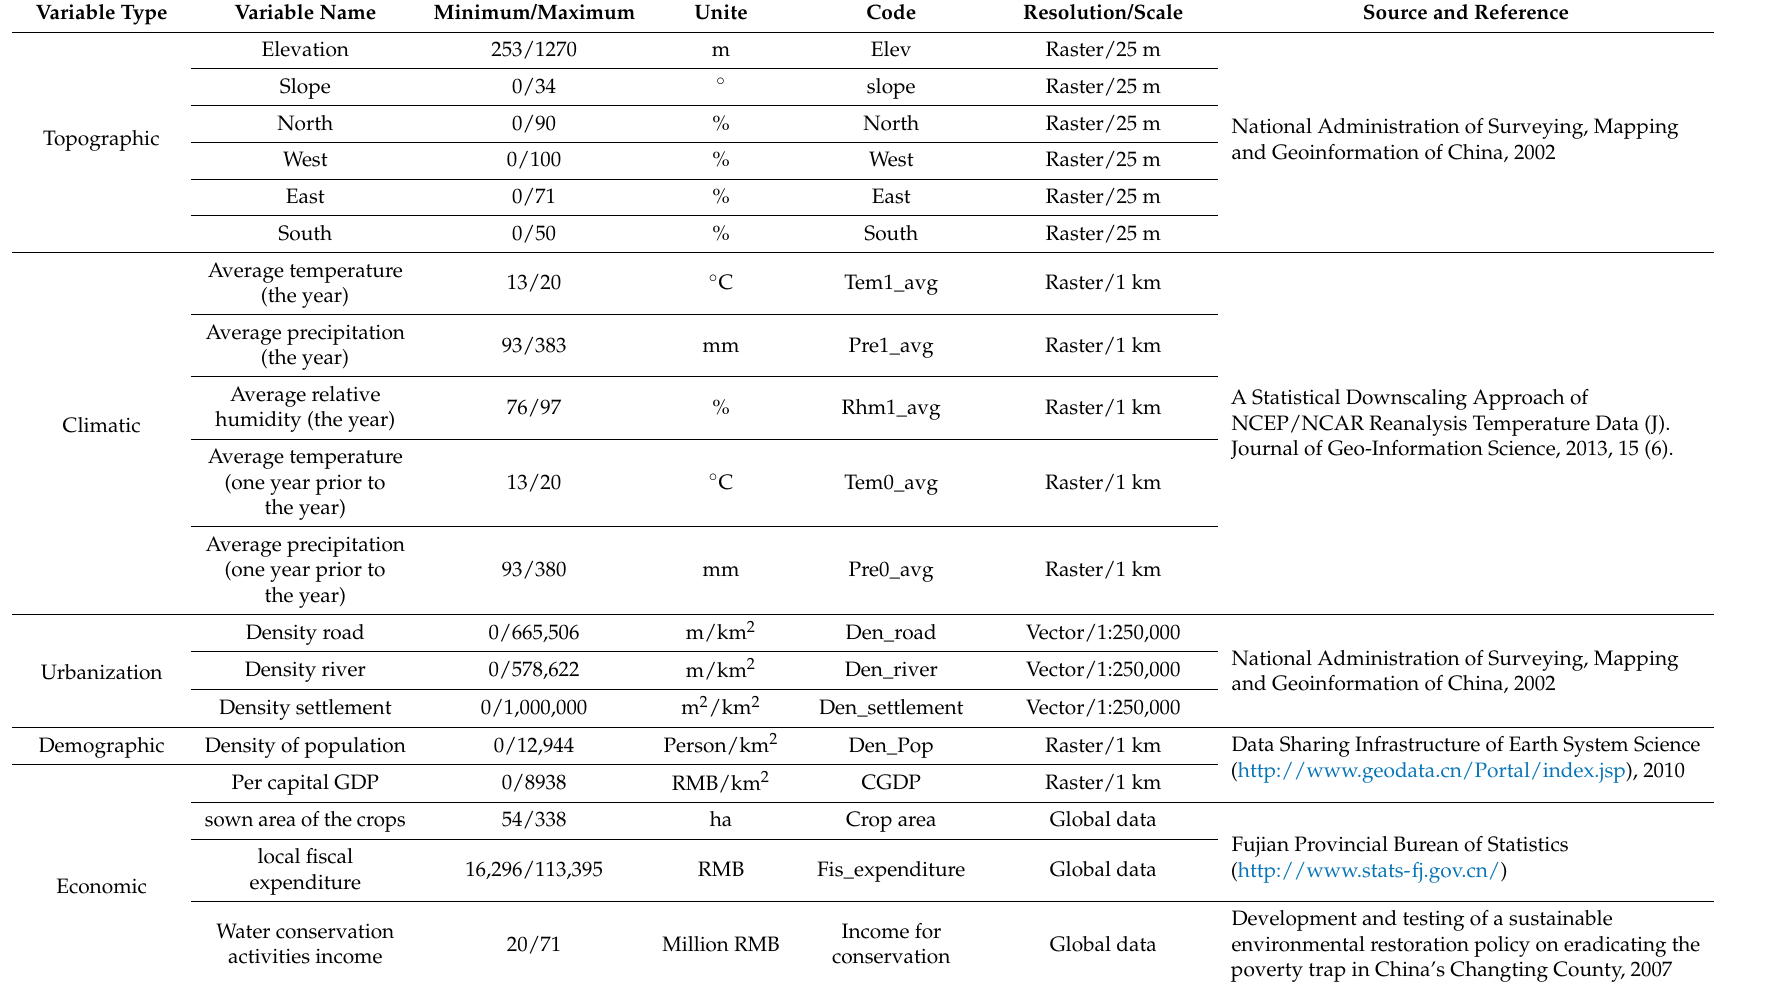
Table 1. Collected variables to be included as predictors in the model. The codes chosen may not include the whole description of the variable for simplicity purposes. Variable